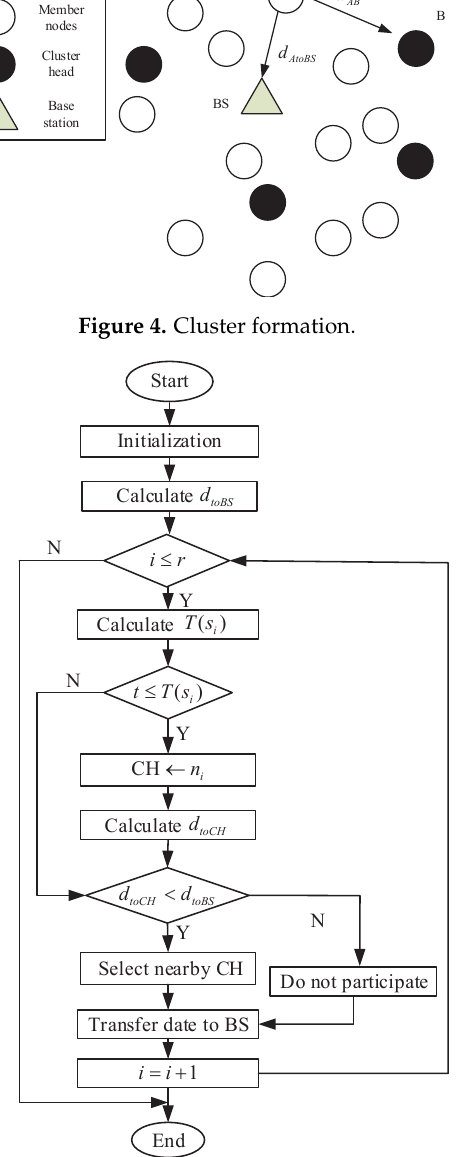
Figure 5. Block diagram of proposed